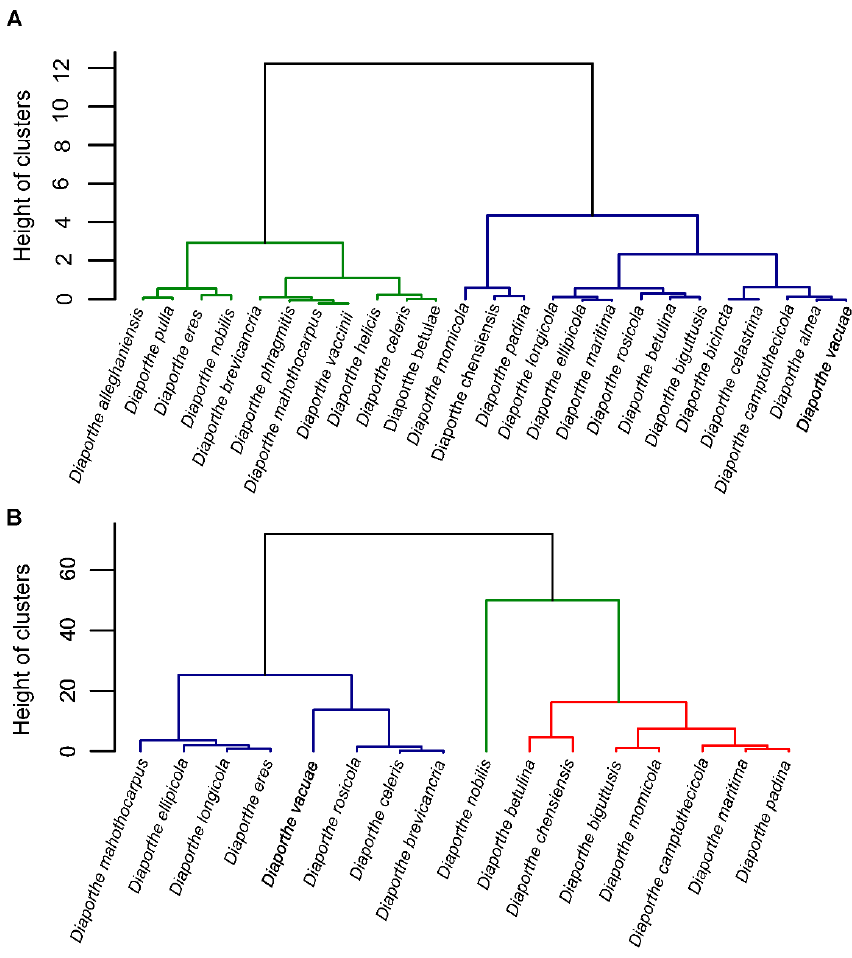
Figure 5. Dendrogram from the hierarchical clustering analysis based on the Ward’s method showing the distribution of the length and width ratio (L/W) of alpha conidia ( A ), beta conidia ( B ) and conidiophores ( C ) of all species isolates from the Diaporthe eres complex. Green, blue and red colors represent the different clusters based on the micromorphological descriptions.